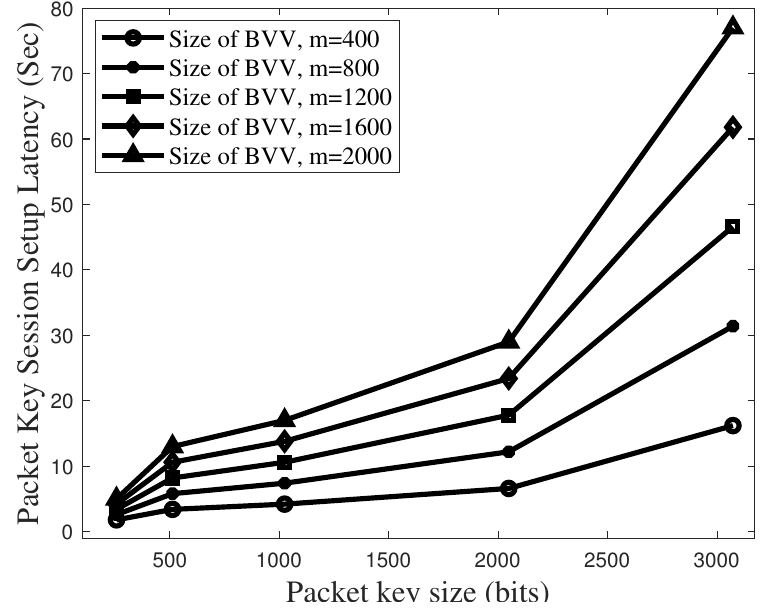
Figure 16. Total latency to set up a packet key-based secure session in the vertical